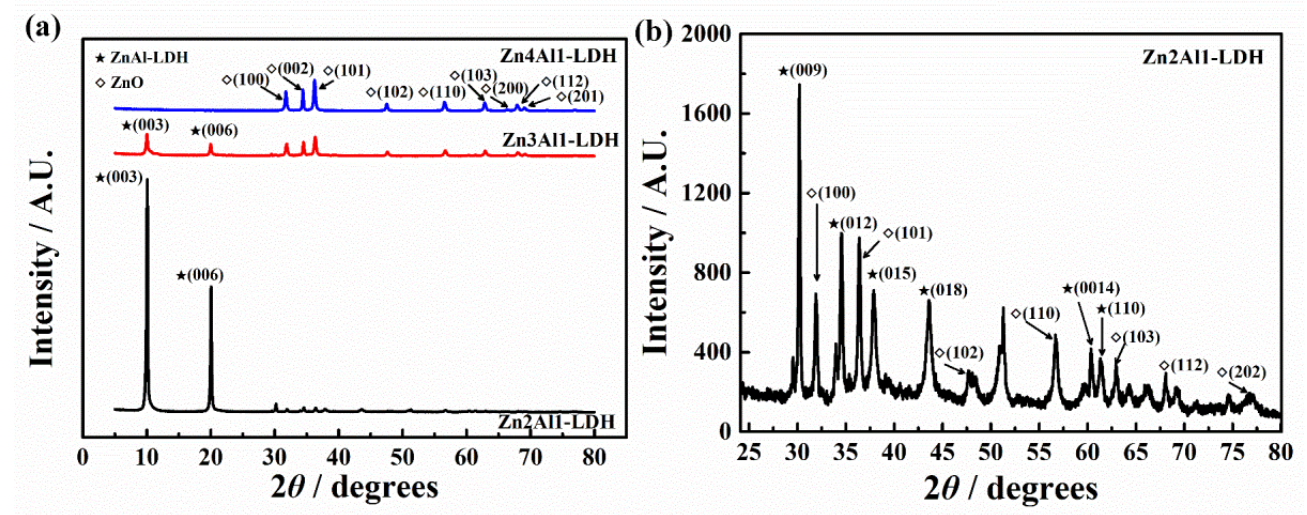
Figure 5. The XRD spectrum of ( a ) Zn2Al1-LDH, Zn3Al1-LDH and Zn4Al1-LDH; ( b ) Zn2Al1-LDH from 24 to 80°.